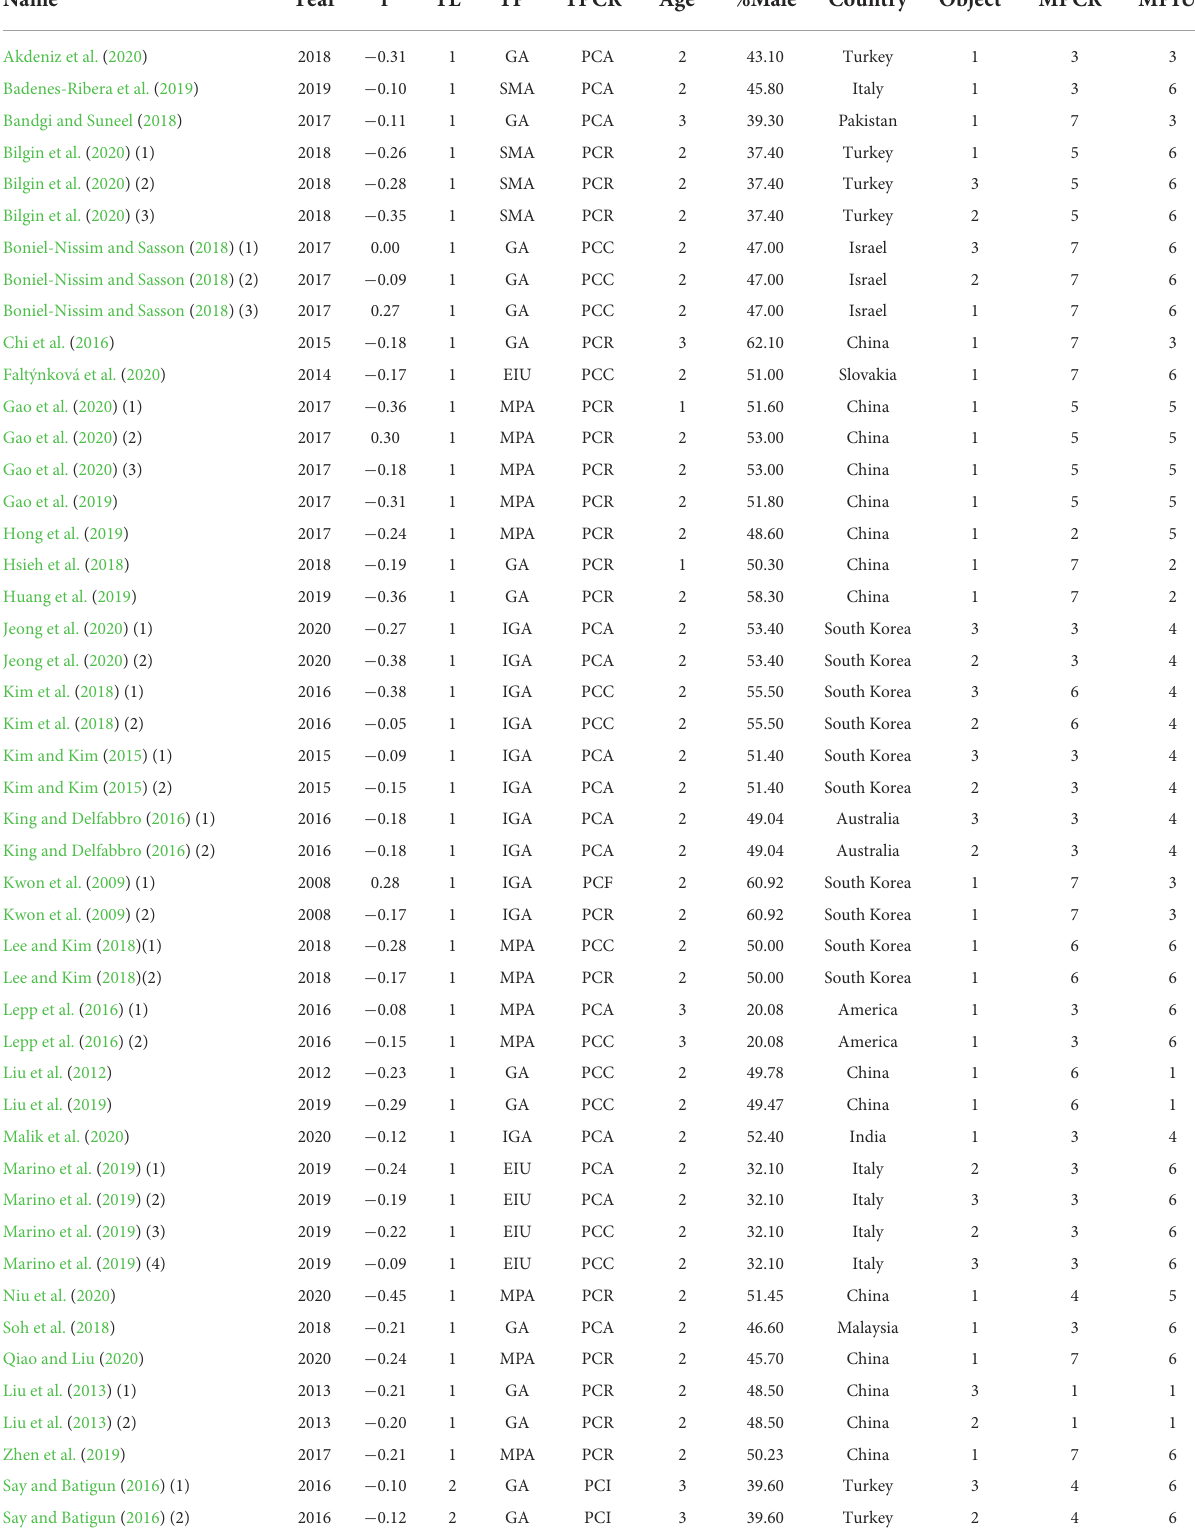
TABLE 2 Characteristics of the 75 studies included in the